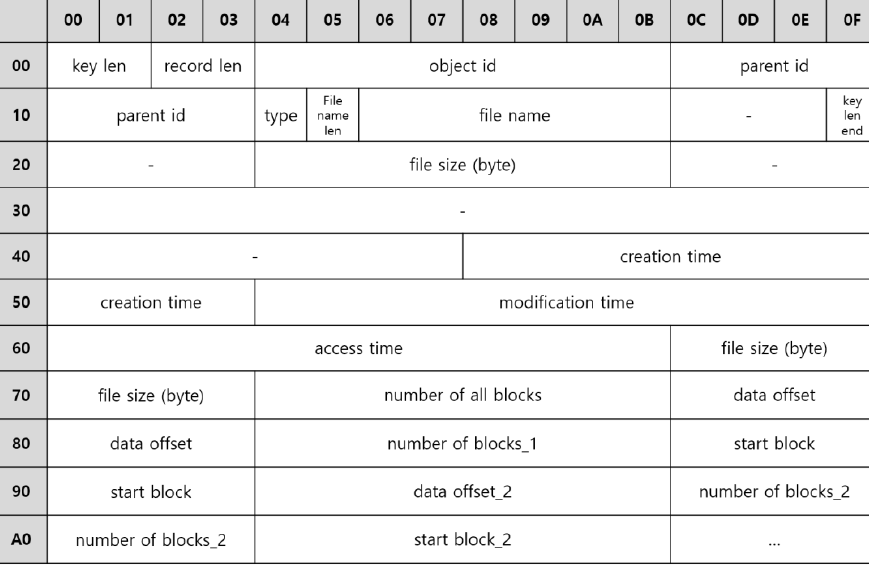
Figure 8. Catalog tree data structure in form of hex